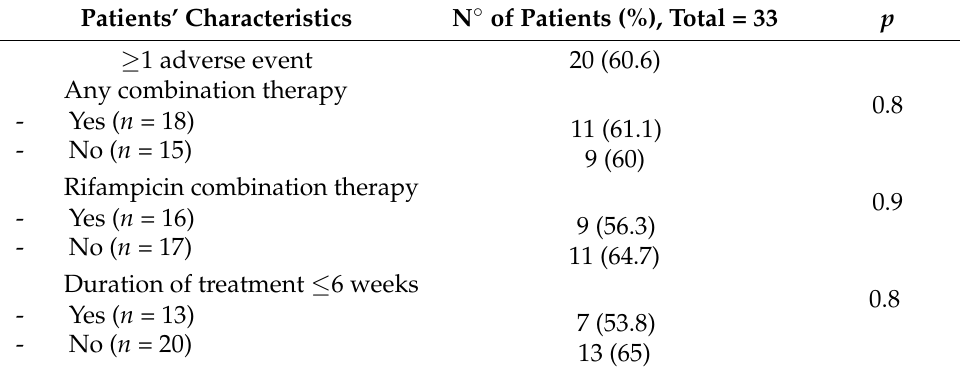
Table 4. Adverse events according to the duration and the antibiotic regimen in 33 patients treated with tedizolid.